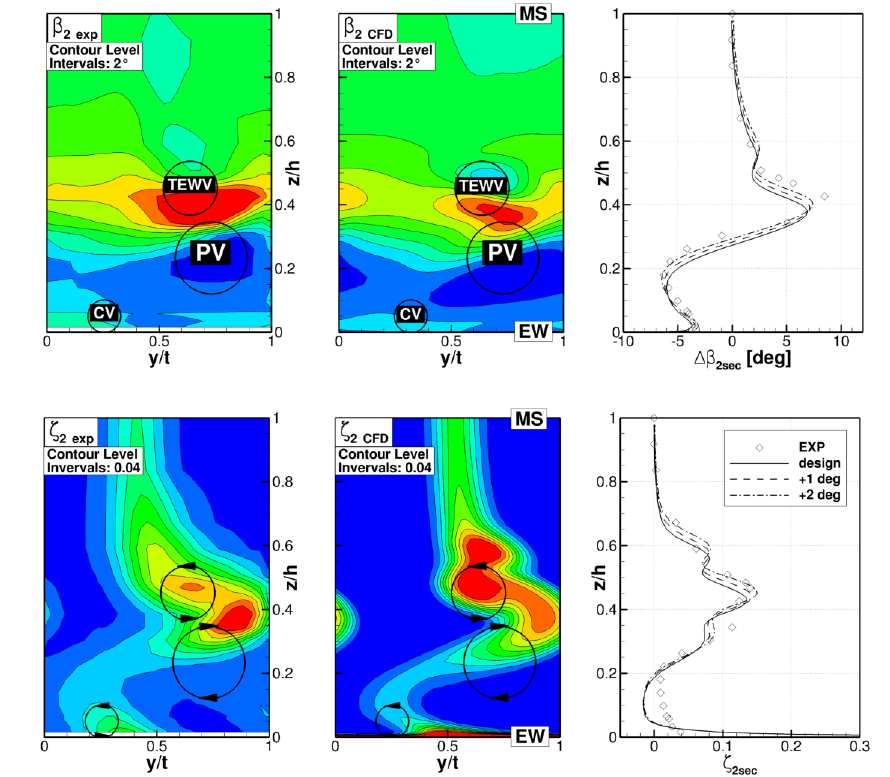
Figure 3. Predicted spanwise distribution of the pitchwise averaged secondary outflow yaw angle ∆ β 2 sec and total pressure losses ζ 2 sec compared to the measured data by Kirik and Niehuis [11] in the measurement plane 2 downstream of the